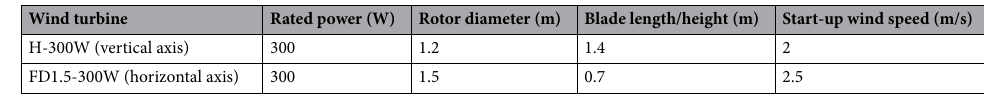
Table 7. Basic parameters of commercial horizontal and vertical axis wind turbines.